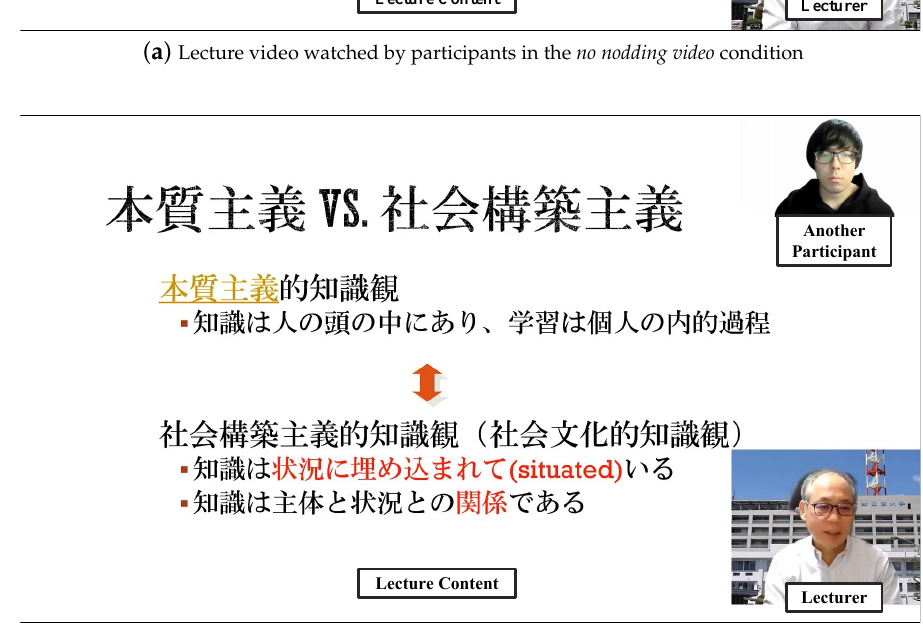
Figure 2. Lecture videos for each